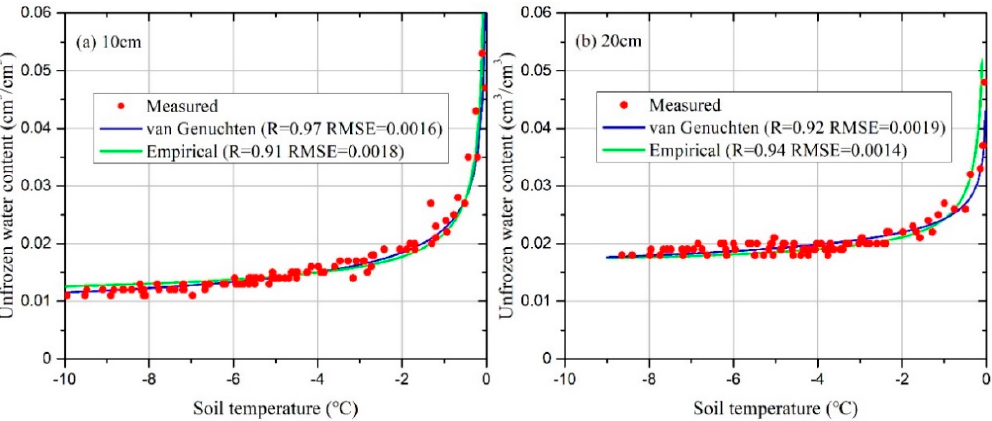
Figure 7. The relationship between the unfrozen soil water content and soil temperature at depths of 10 ( a ) and 20 ( b ) cm. Figures show experimental data, as well as the van Genuchten (Equation (5)) and empirical (Equation (6)) functions. R is the correlation coefficient, and RMSE is the root mean square error (cm 3 / cm 3 ). Table 5. The fitted parameters for the van Genuchten and empirical models. Van Genuchten Depth (cm)